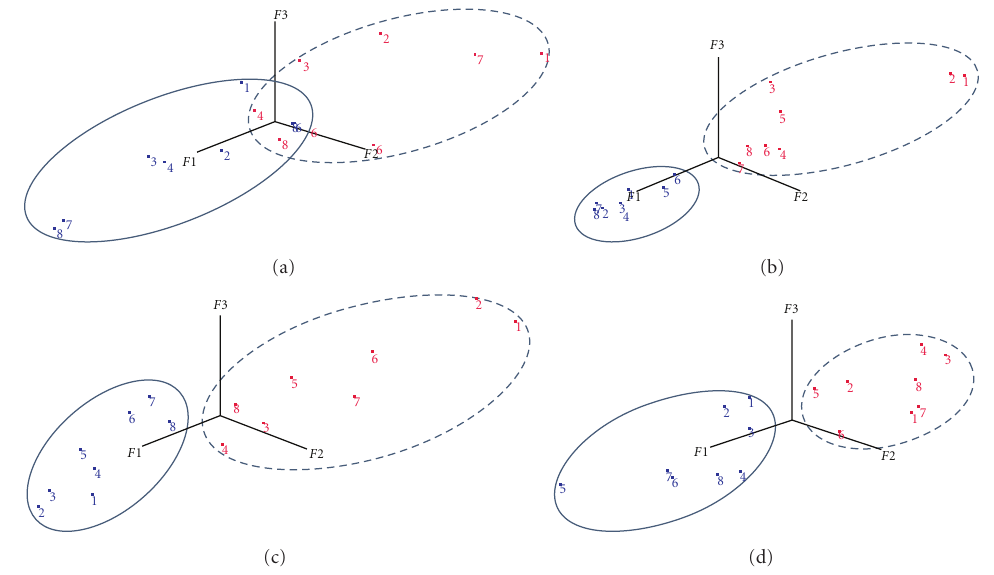
Figure 3: Principal components plot of E-nose sensor responses to headspace VOC emissions from unexposed cotton bolls (solid ellipsoids) and bolls exposed to Nezara viridula (dashed ellipsoids) after 24 (a), 48 (b), 72 (c), and 96 (d) hr of feeding.